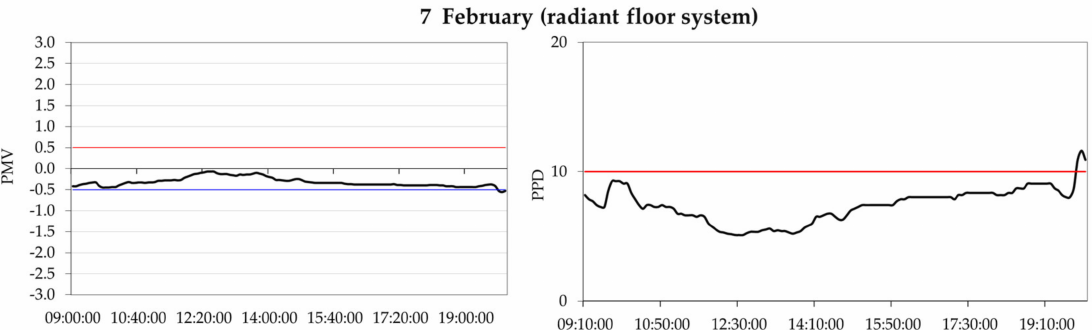
Figure 5. PMV and PPD calculation: radiant floor system.